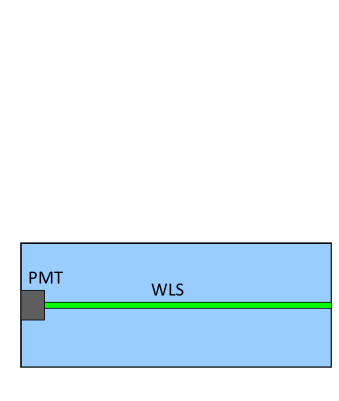
Figure 5. Scheme of the ASHIPH